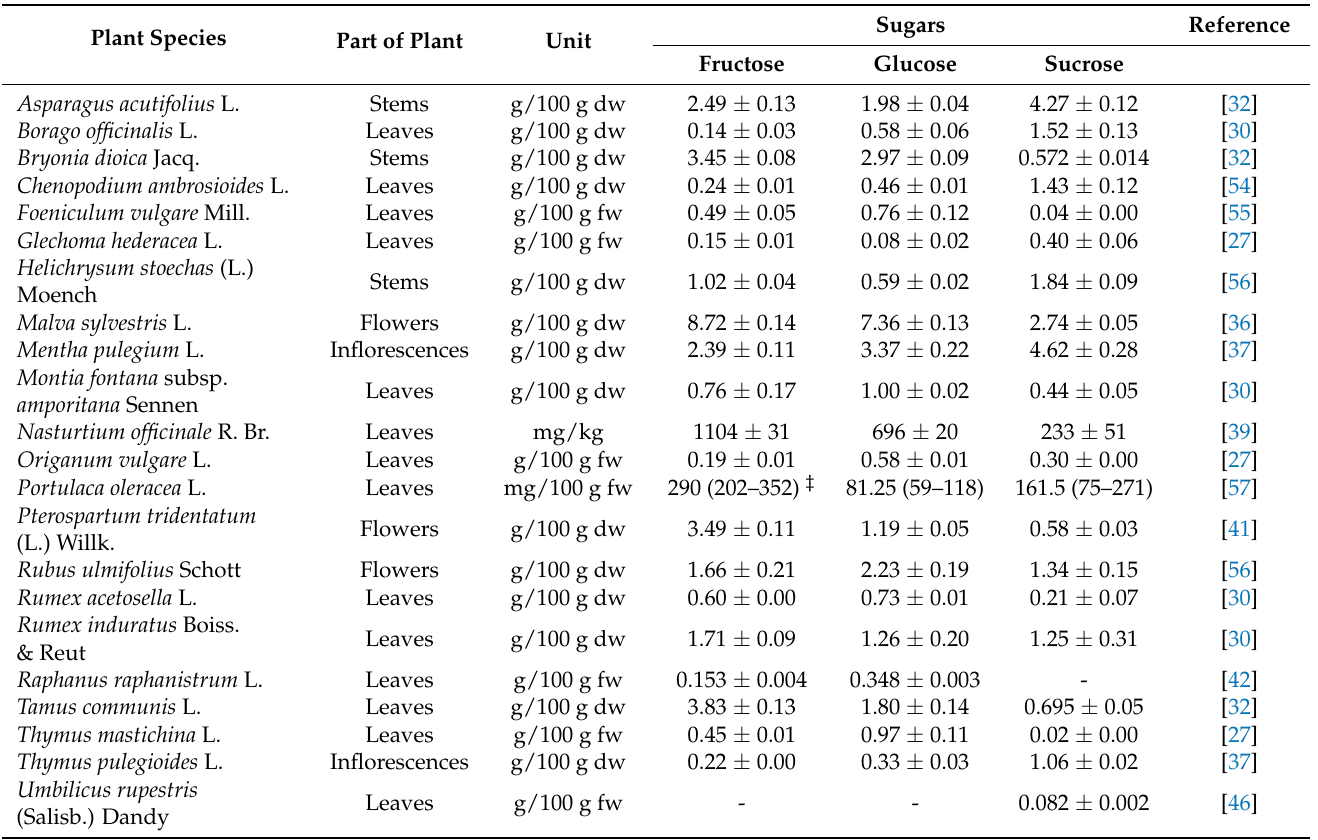
Table 2. Sugars reported in wild edible plants,